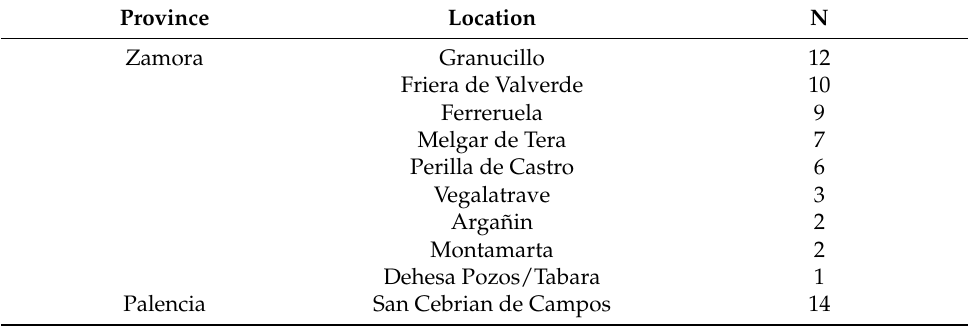
Table A1. Location and number of wild boar samples (N) from each